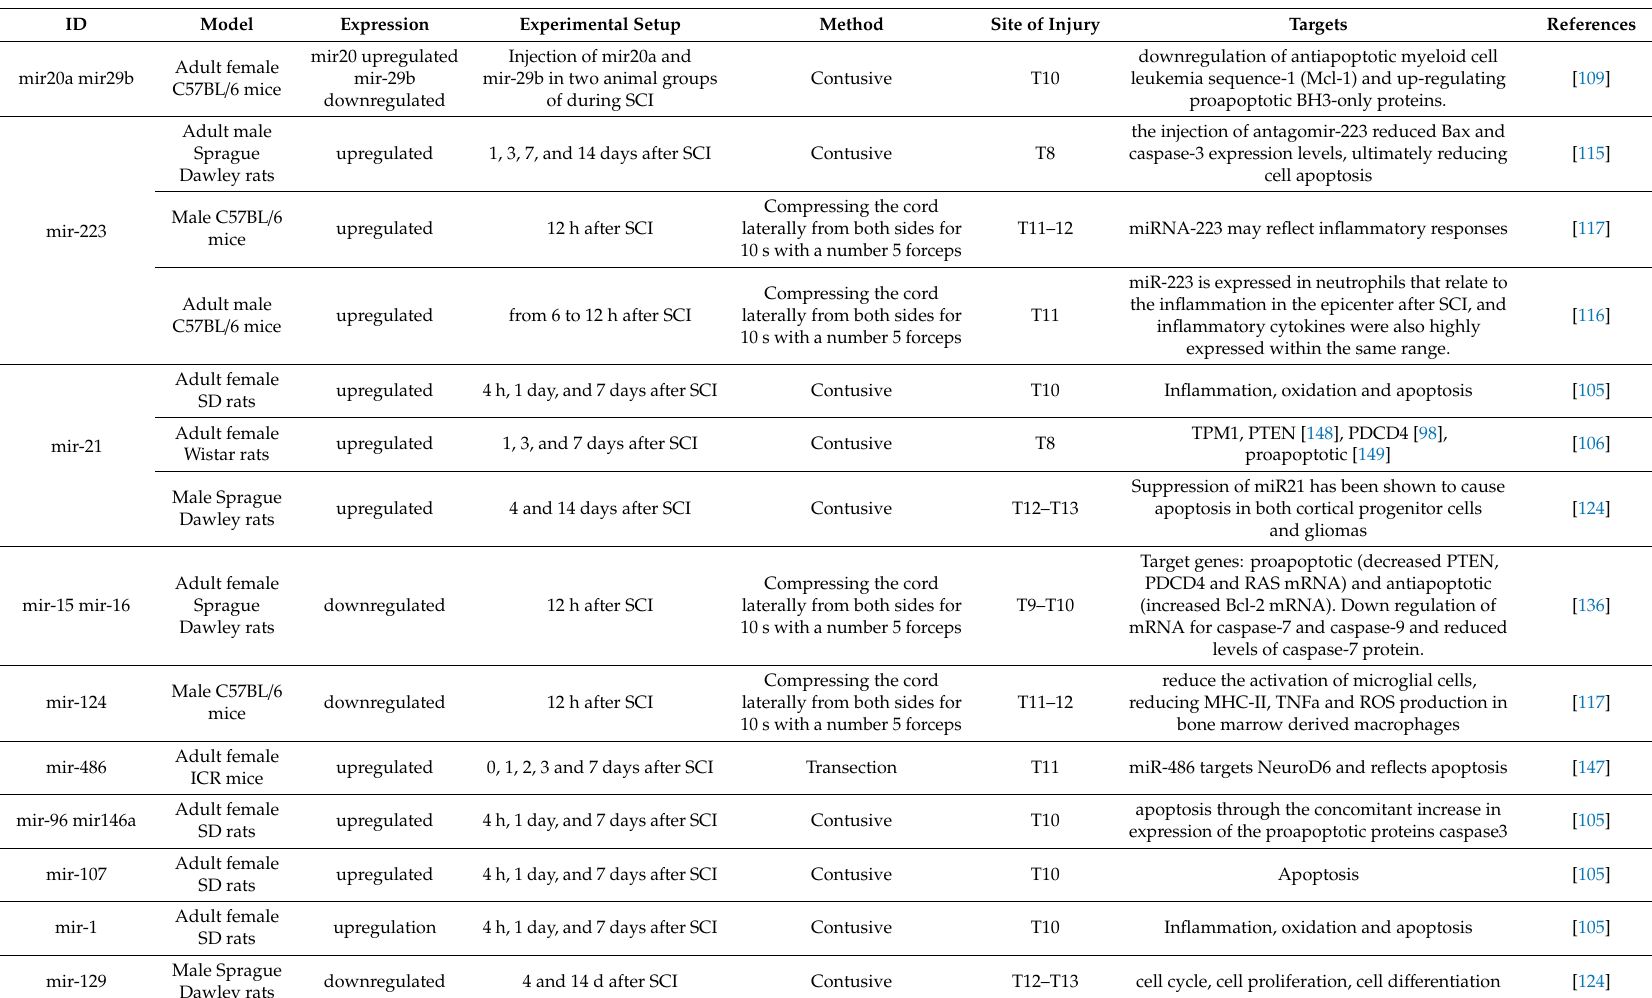
Table 1. Roles of di ff erent miRNA in